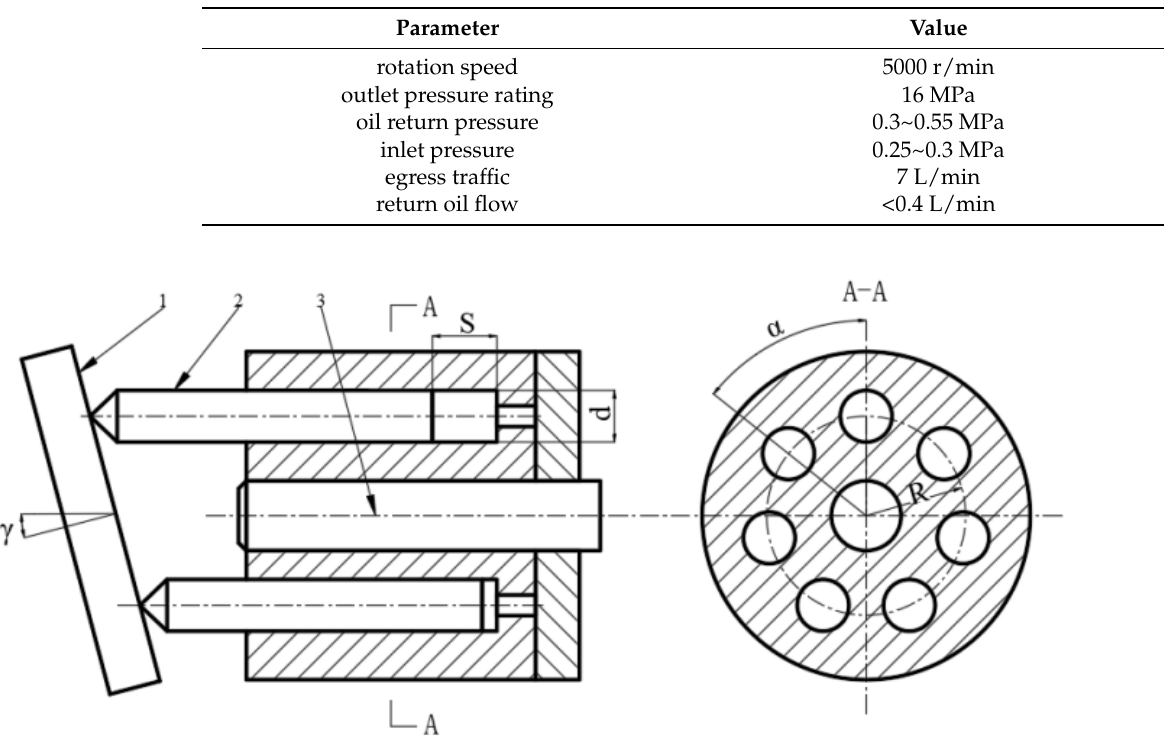
Figure 4. Plunger pump structure (1: swash plate; 2: plunger; 3: pump shaft).